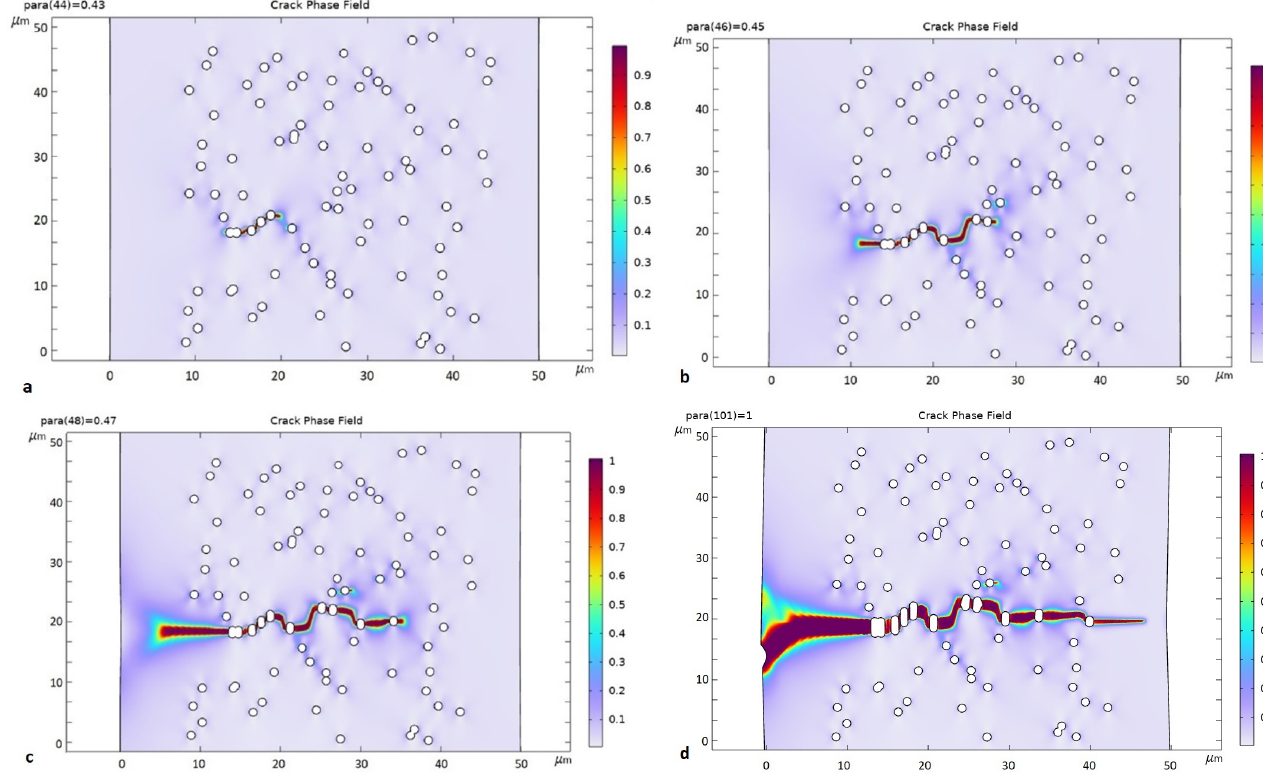
Figure 9. Simulation of the plastic–elastic deformation of TMs by the net-point method at one axis extension. The direction of the extension is horizontal. Dark-red zones correspond to zones with maximum stress concentrations; green represents zones of unloading.